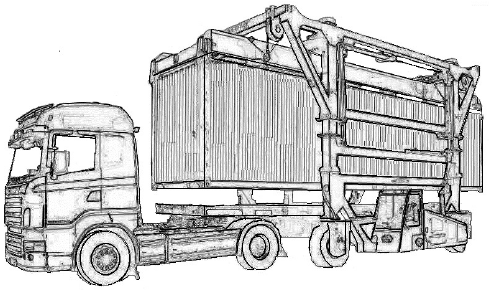
Figure 4. On-board lift.